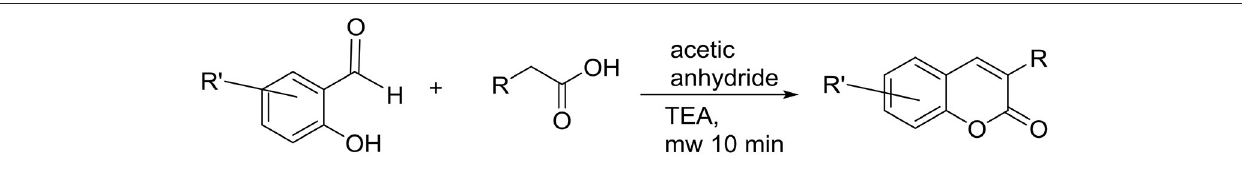
N/A = not available. Controls: ( 1 ) pargyline, ( 2 ) clorgyline, ( 3 ) kit control. The compounds are grouped (A–F) based on the chemical similarity of the R1–R7 substituents ( Figure 1E ).